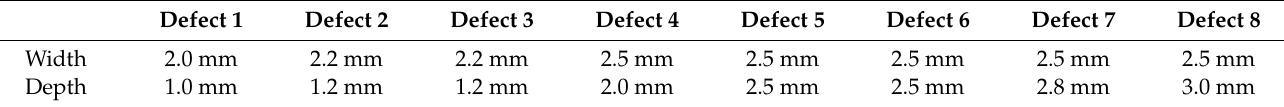
Table 1. The width and depth of each defect.